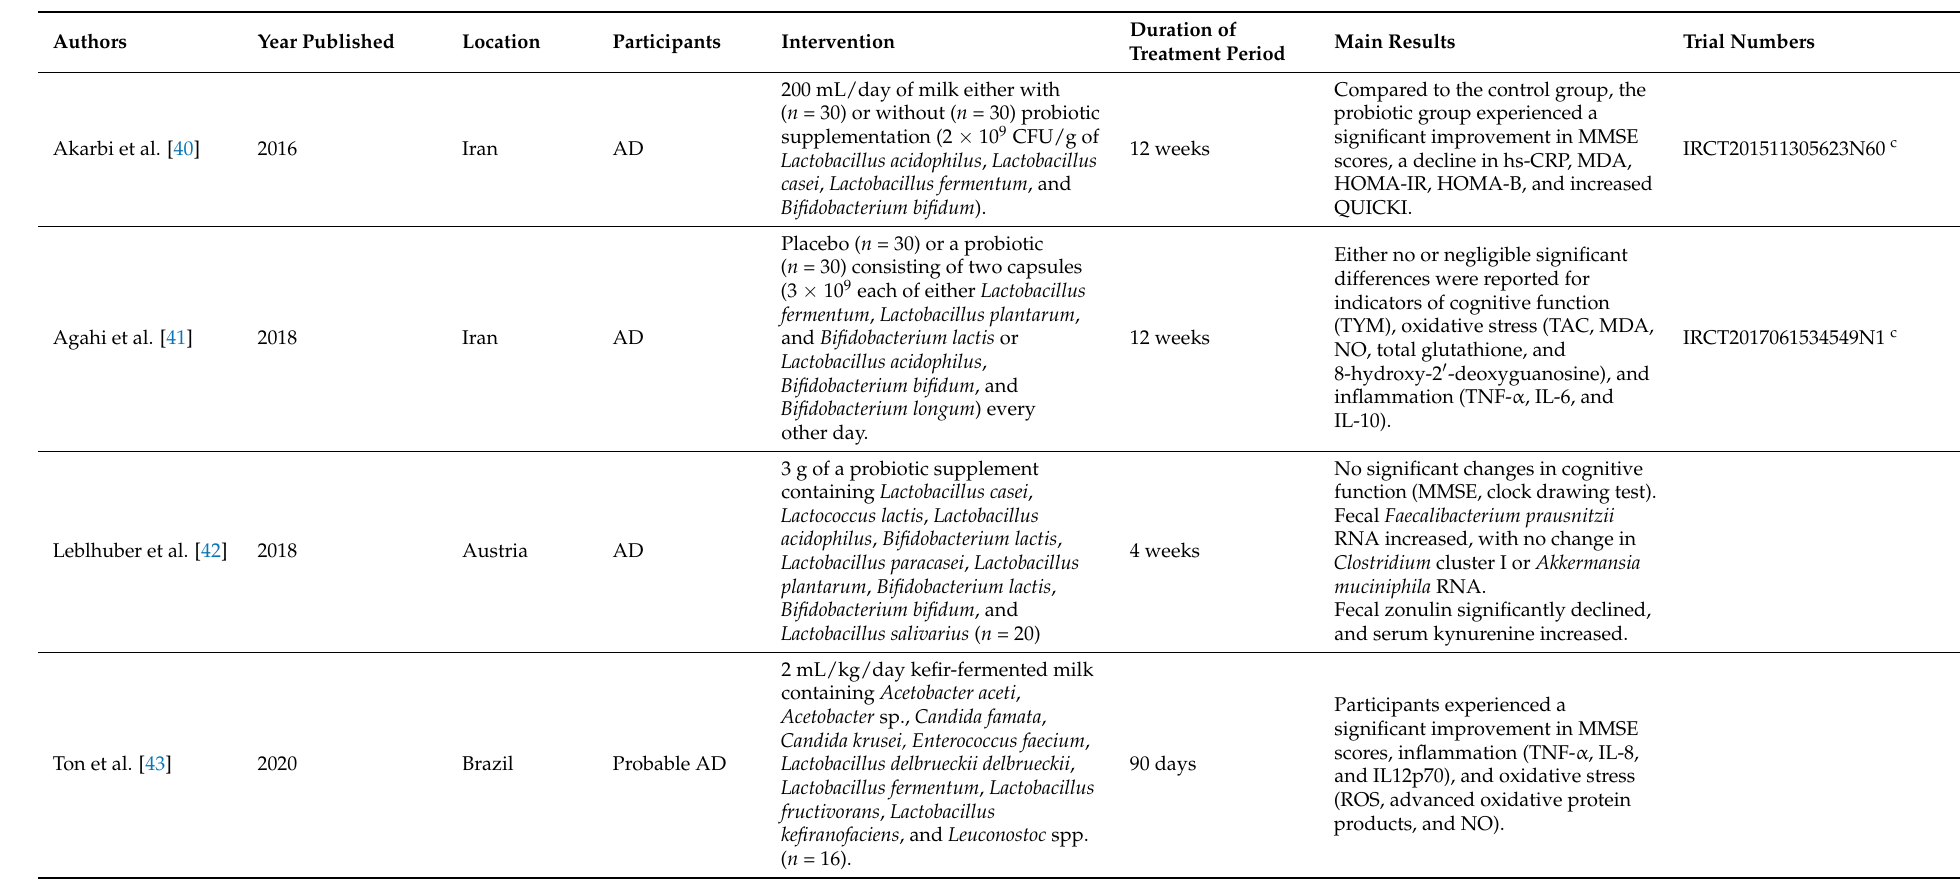
Table 1. Summary of Clinical Trials on Antioxidant Supplementation in Individuals with